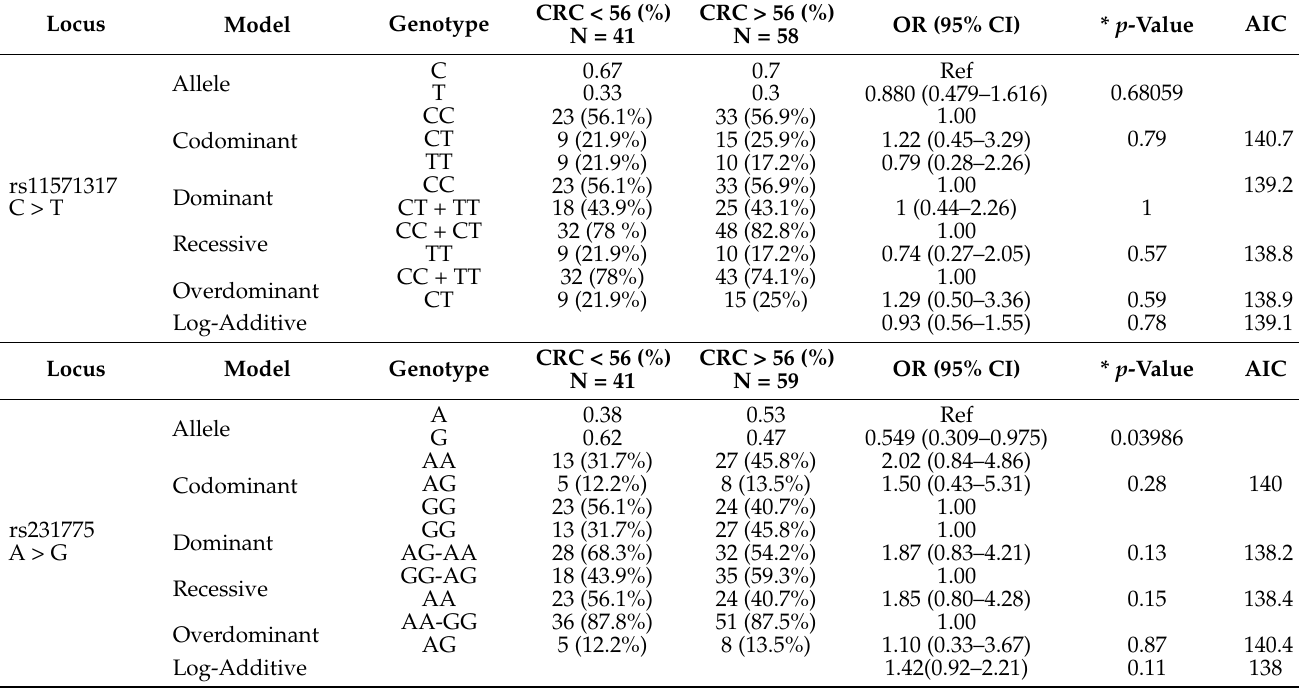
Table 4. Association of CTLA-4 with colorectal cancer cases after age stratification. CRC, colorectal cancer; OR, odds ratio; 95 % CI, 95 % confidence interval. * p < 0.05 was considered